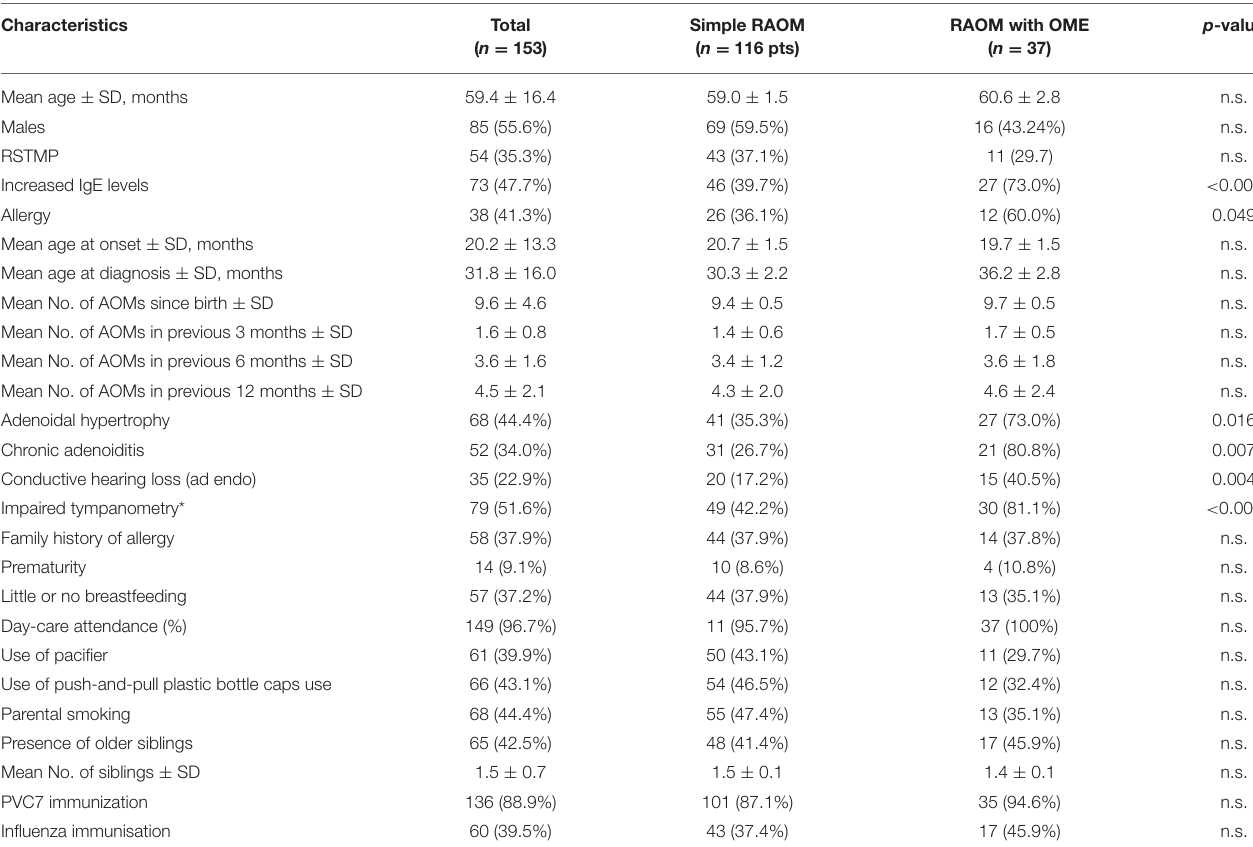
TABLE 1 | Demographic and clinical characteristics of the study population as a whole and by the clinical phenotypic pattern of disease. Characteristics